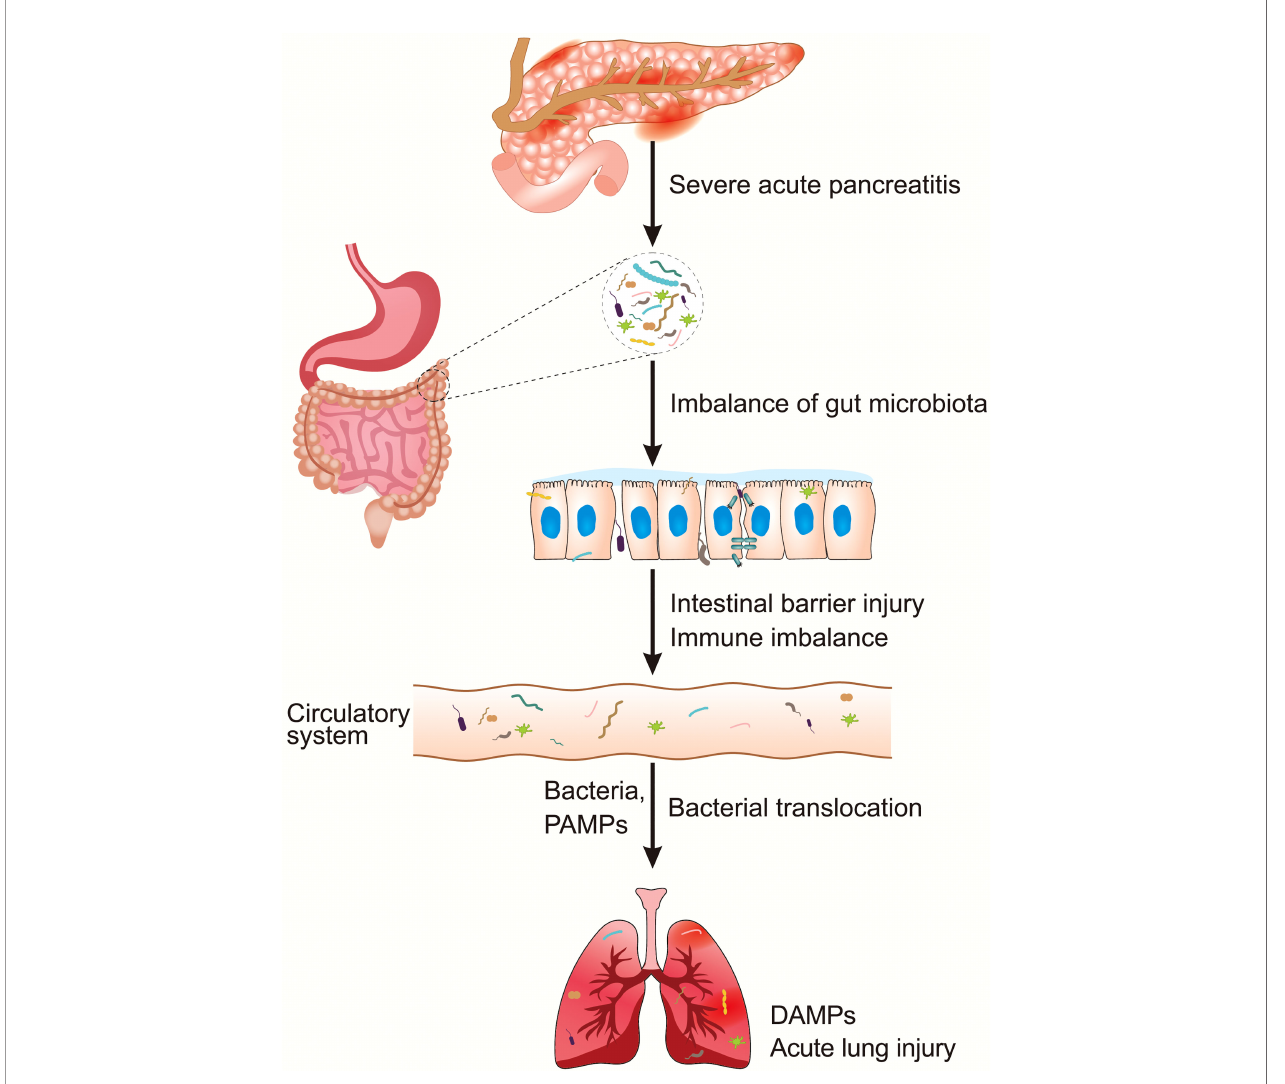
FIGURE 1 | An overview of intestinal microbiota dysbiosis in PALI. DAMPs, damage-associated molecular patterns; PALI, severe acute pancreatitis-associated acute lung injury; PAMPs, pathogen-associated molecular